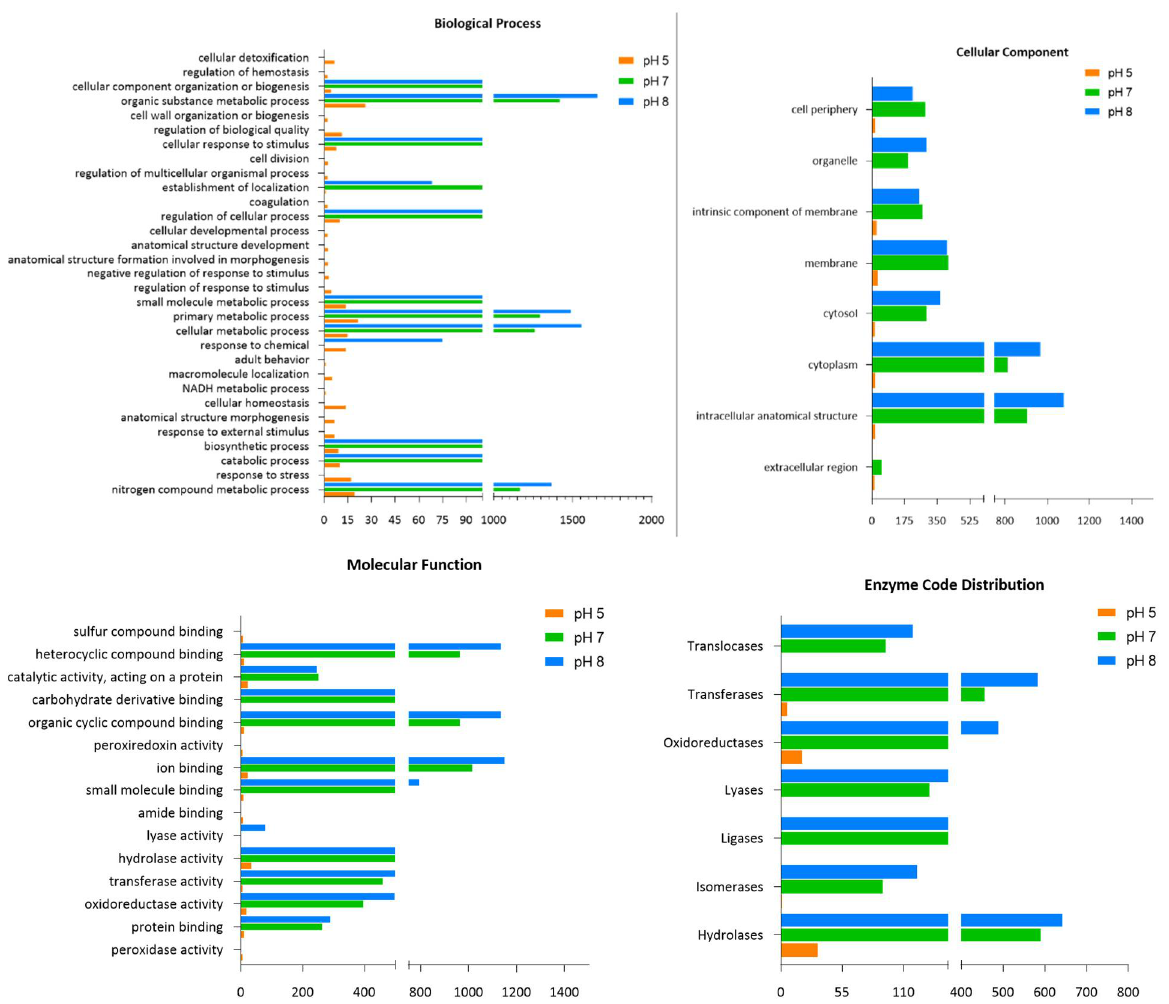
Figure 5. Variation in the biological processes, cellular components, molecular function and enzyme code distribution of proteins based on the GO enrichment analysis of B. subtilis obtained from CFS when cultured at pH 5, 7 and 8.